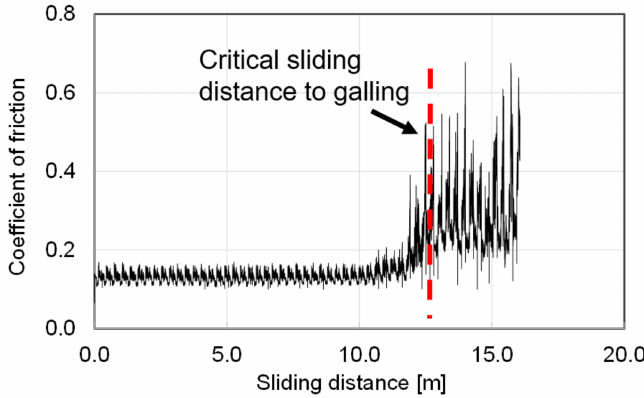
Figure 6. The coe ffi cient of friction (COF) as a function of sliding distance for V40 tested against CP1180HD at 60 N (860